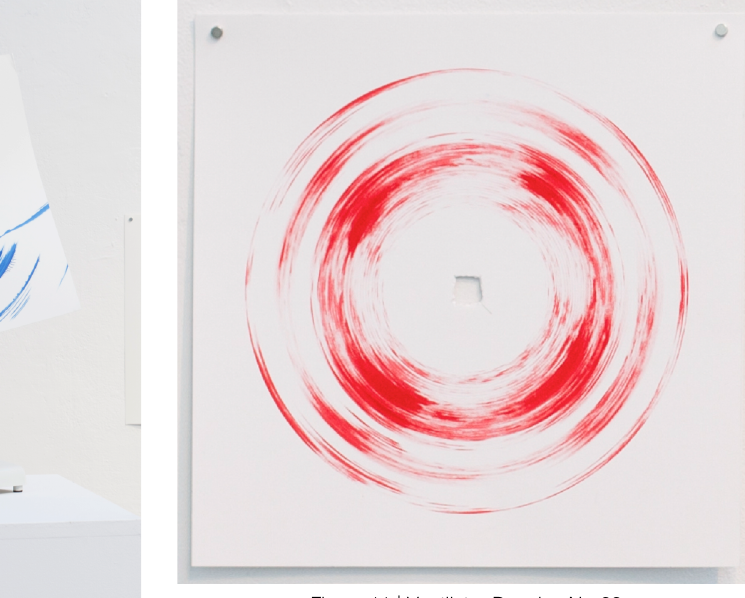
Figure 11 | Ventilator Drawing Nr. 22.